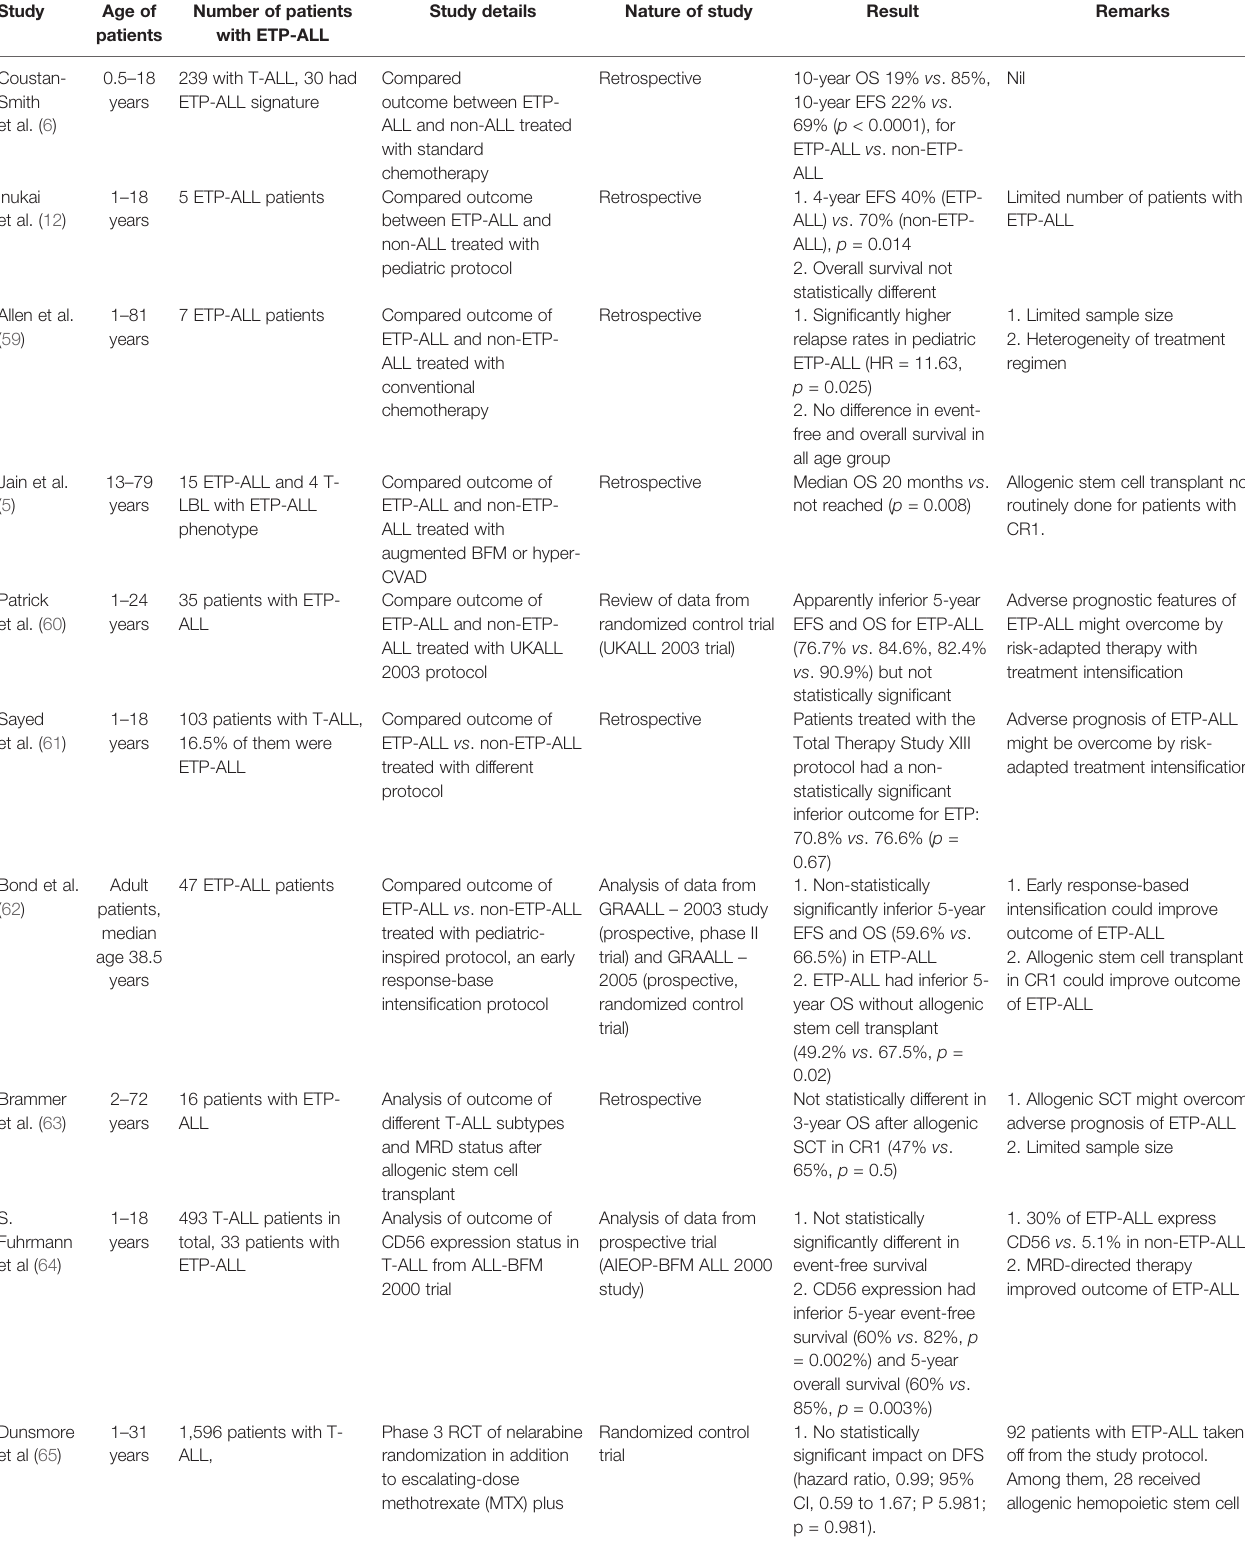
TABLE 7 | Clinical studies of evaluating the outcome of